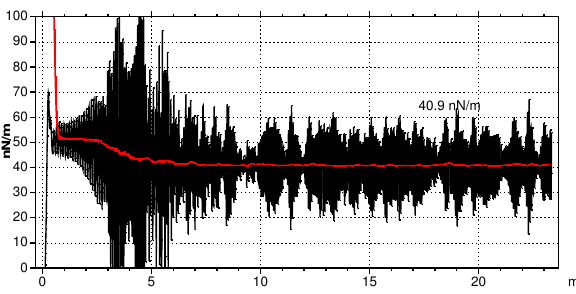
Figure 13. Run BxLong: B x = 30 000nT and 23.4ms duration.